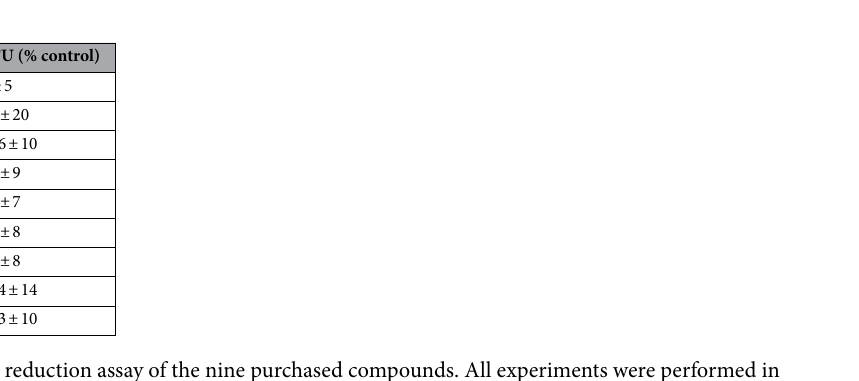
Table 1. Plaque reduction assay of the nine purchased compounds. All experiments were performed in triplicate. Plaque-forming unit (PFU) values are shown as the mean ± standard deviation.